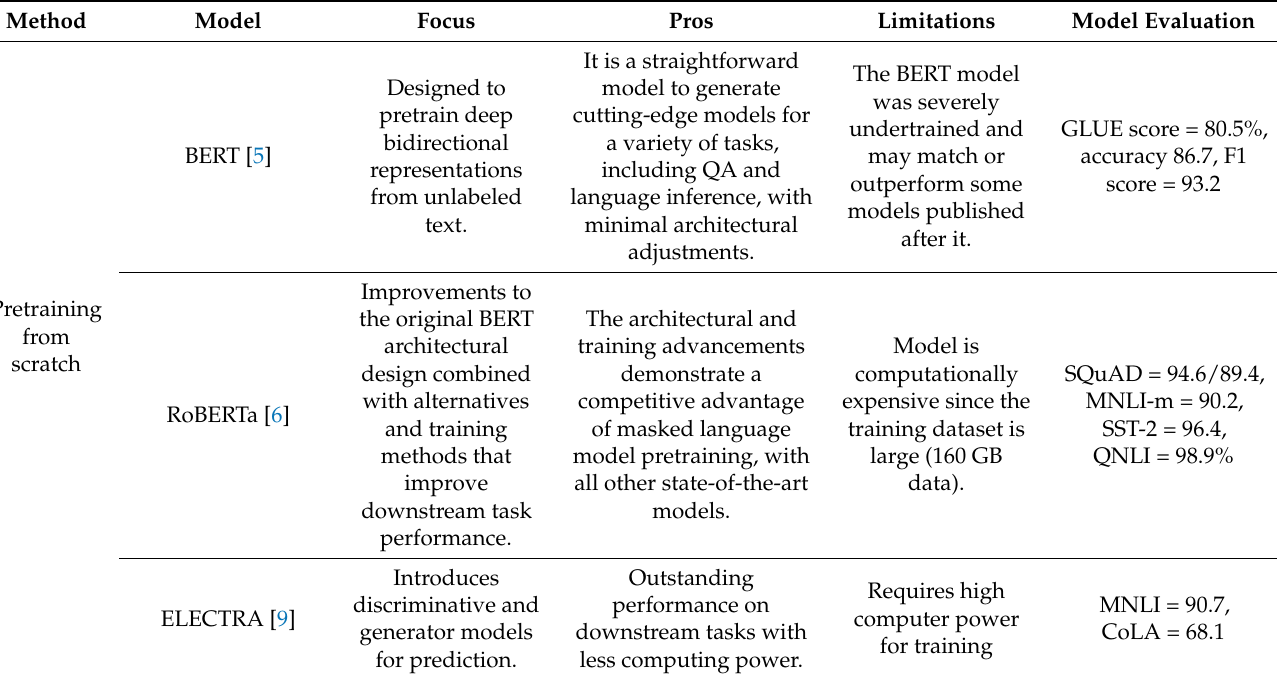
Table 4. Summary of pretraining techniques employed for language